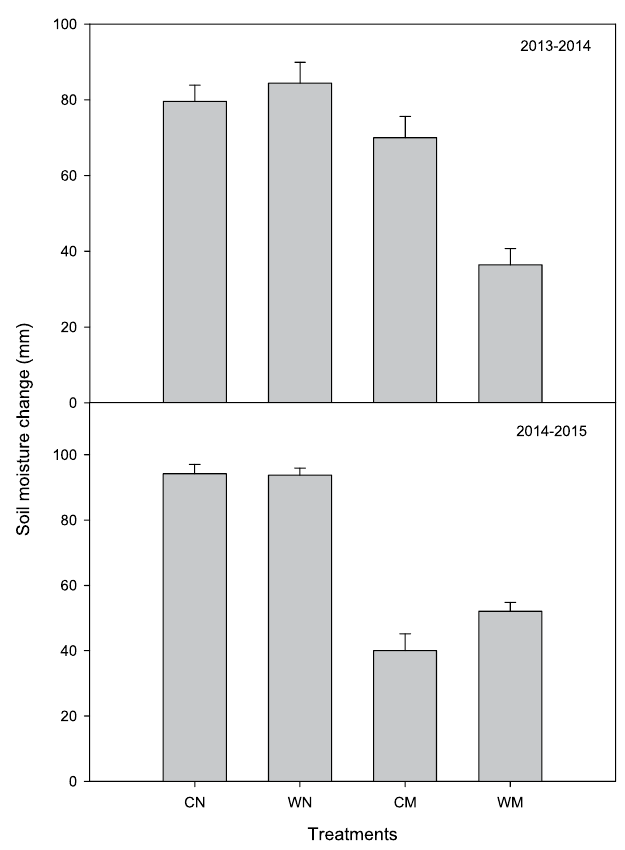
Figure 3. Soil moisture change in 2013–2014 and 2014–2015 winter wheat growing seasons. WN represent wide-precision planting with non-mulching, CN represent conventional-cultivation planting with non- mulching, WM represent wide-precision planting with straw mulching, and CM represent conventional- cultivation planting with straw mulching, respectively. Vertical bars are standard